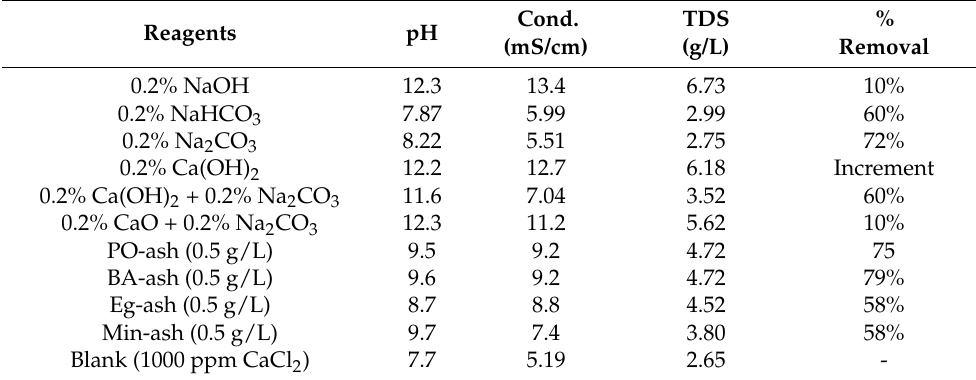
Table 6. Comparison of common chemical precipitation methods with agro-ash.